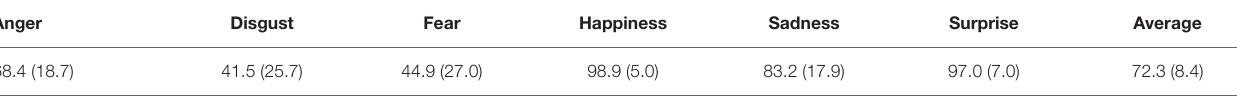
TABLE 3 | The mean percent accuracy (SD) for the emotion-recognition task. Anger Disgust Fear